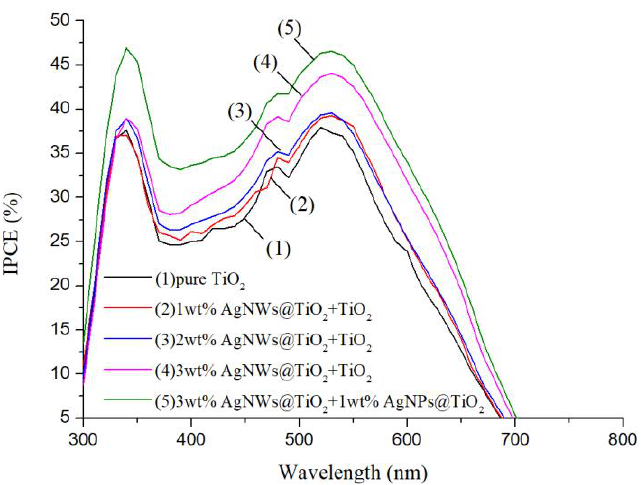
Figure 6. Incident photon-to-electron conversion efficiency (IPCE) curves of the dye-sensitized solar cell (DSSCs) with containing different